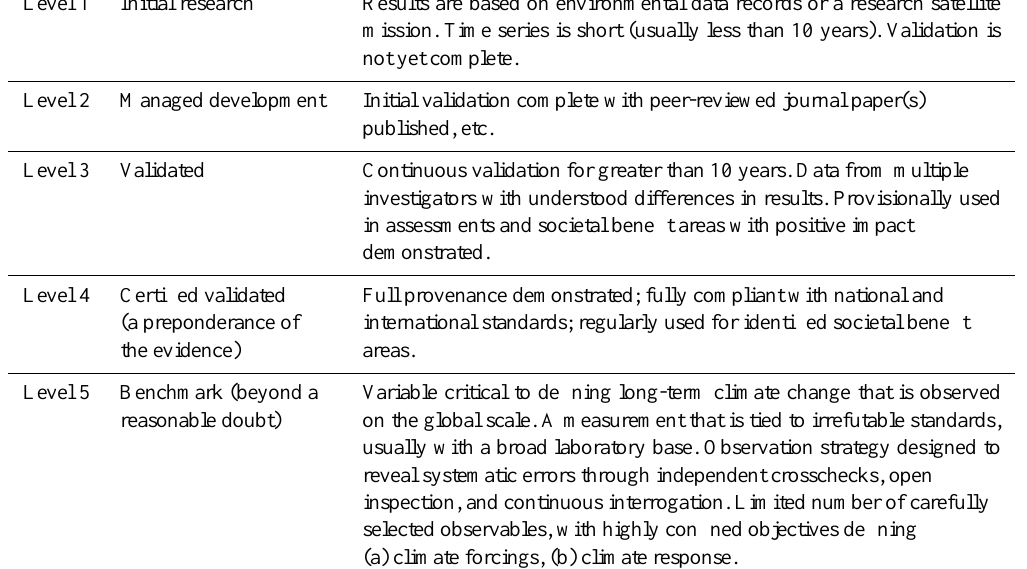
Figure 7. The sequence of scientific output needed to underpin satellite observations. The instrument, calibration, and algorithm descriptions may be contained in one or more publications. Significant iterations of the retrieval algorithm are usually described in a new publication. Table 3. Levels of system maturity, as defined in Bates and Barkstrom